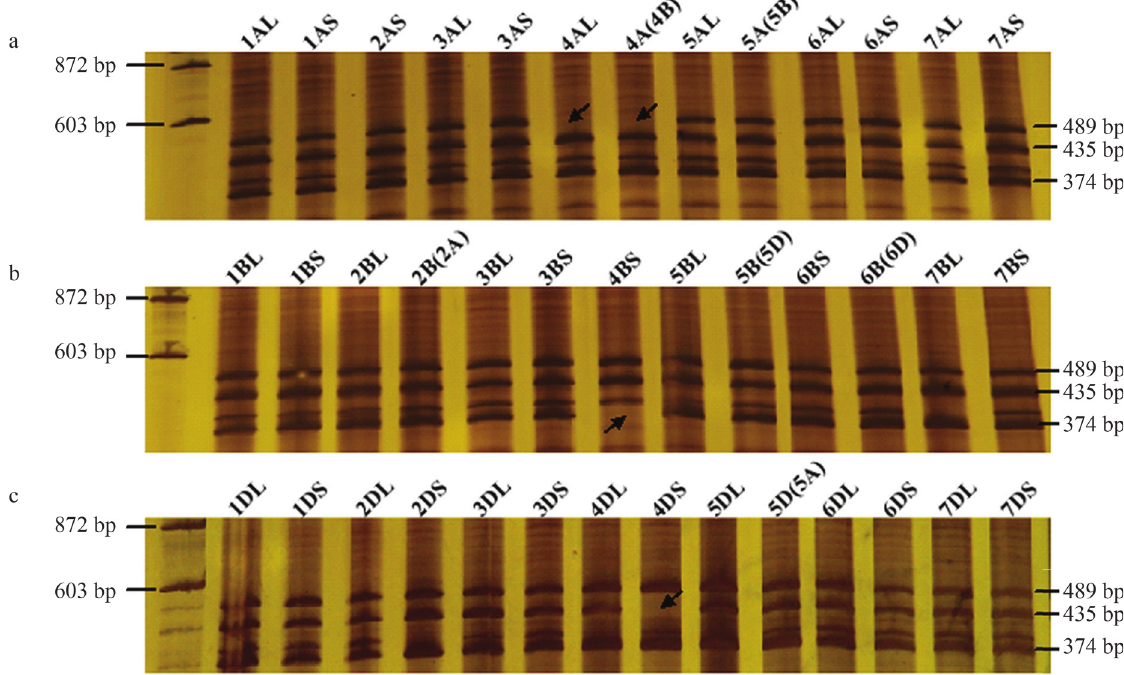
Figure2 -ChromosomemappingoftheTaEGgene.DNAsizemarkersareshownontheleftofthegel.(A)TaEG-4Alocatedonthelongarmofchromo- some4A.(B)TaEG-4Blocatedontheshortarmofchromosome4B.(C)TaEG-4Dlocatedontheshortarmofchromosome4D.Missingfragmentsarein- dicated by